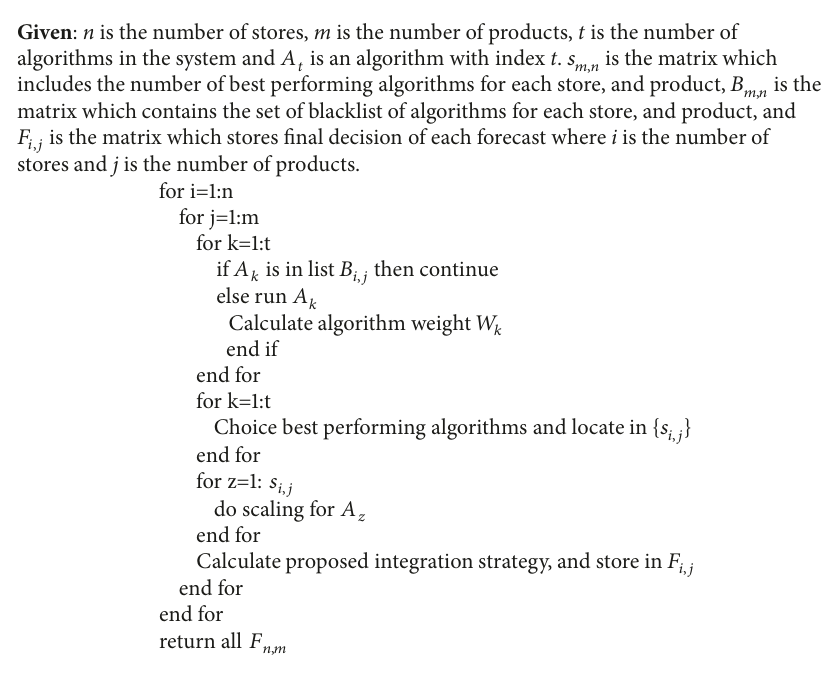
Algorithm 1: The algorithm of the proposed demand forecasting